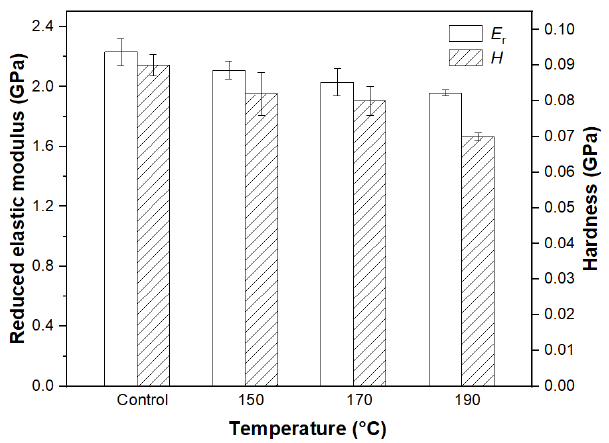
ff ects of thermal modification on the E Figure 6. Effects of thermal modification on the E r and H of the coating. Figure 6. E